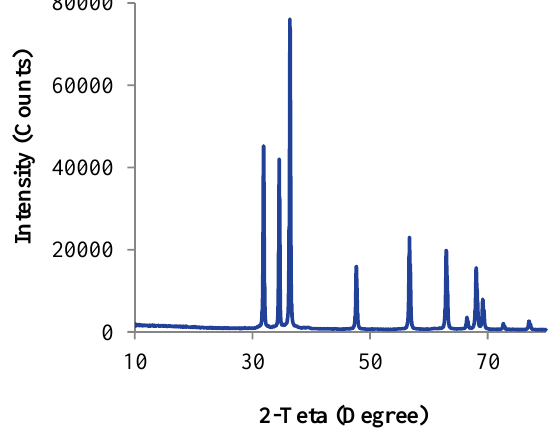
Figure 3. X-ray diffraction (XRD) pattern of ZnO